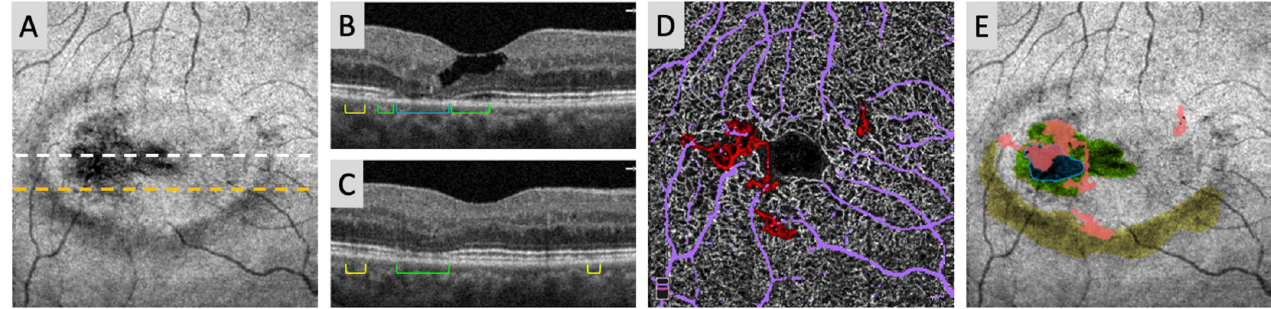
Fig 1. Identification and grading of DCP telangiectasia, IZ attenuation, IZ loss, and EZ loss in MacTel eyes. (A) Right eye of a 59-year old female with nonproliferative (OCT stage 3) MacTel. En face images of a manually defined OCT slab located between the inner segment-outer segment (IS/OS) junction and 15 μ m above the RPE were used to identify areas of potential hyporeflectivity in the IZ and EZ layers and cross-referenced with the OCT cross-sectional B- scans (B–white dashed line; C–orange dashed line) to delineate areas of IZ attenuation (yellow), IZ loss (green), and EZ loss (blue; outlined for clarity). (D) Grading of DCP telangiectasia (red) and large superficial vessel overlay (lavender) in the same eye. (E) Overlap of circumscribed regions of DCP telangiectasia with IZ attenuation, IZ loss, and EZ loss areas described in (A).